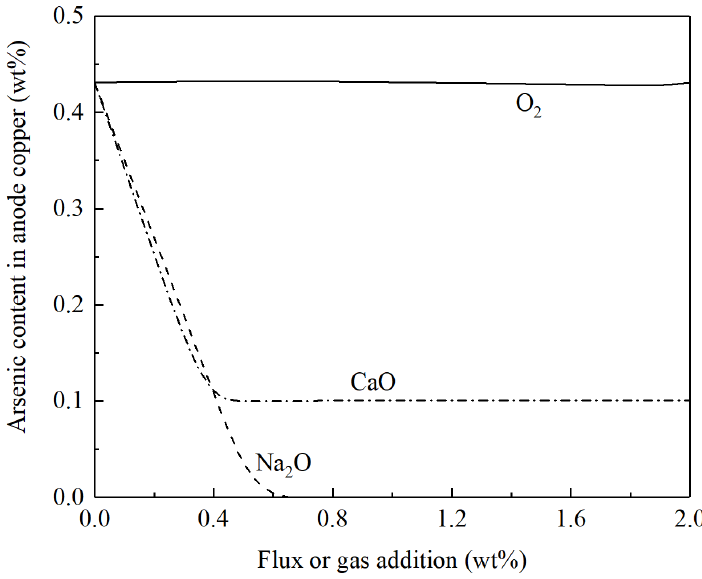
Figure 7. Effect of flux and oxygen on arsenic content in anode copper at 1200 °C.